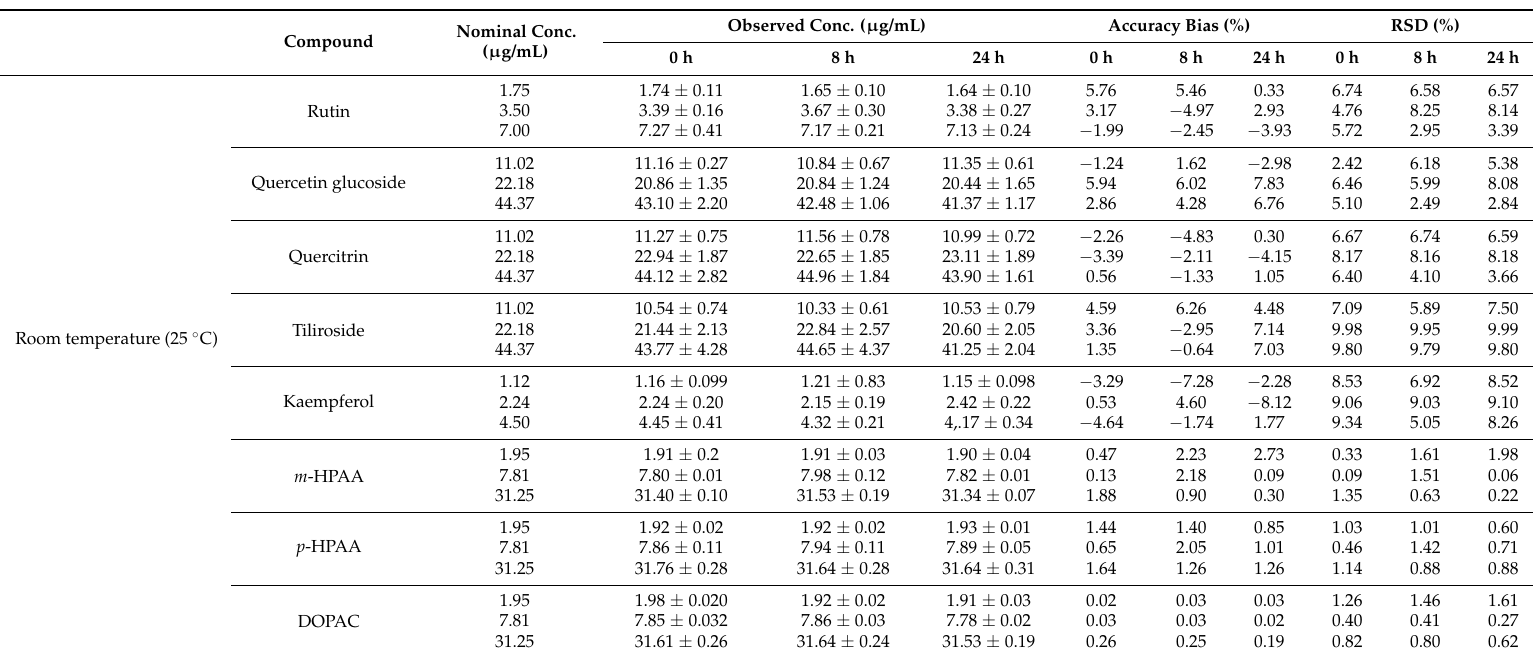
Table 1. Stability profile of anxiolytic T. americana flavonoid fractions or the flavonoid biotransformation products found in mouse plasma (matrix) under different handling conditions, ( n =